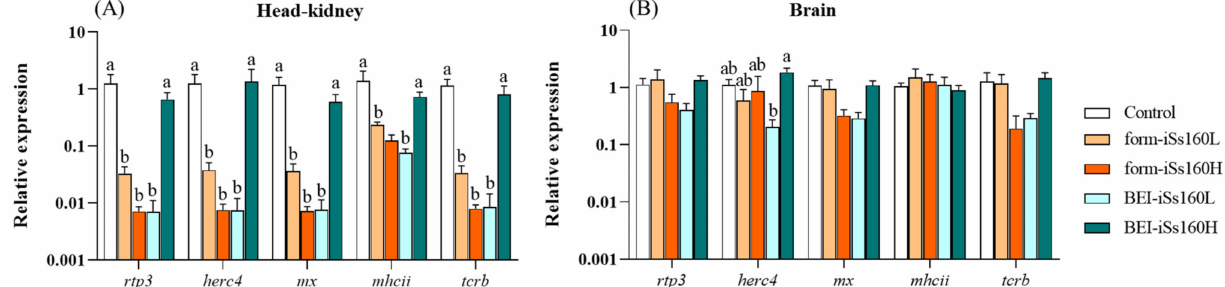
Figure 6. Vaccination mainly decreases the immune response upon NNV infection at a transcriptional level in head-kidney but not in brain. Expression of immune-related genes in ( A ) head-kidney and ( B ) brain of Senegalese sole specimens 45 days after 3 h of immersion with 10 5 TCID 50 /mL of Ss160 in fish previously vaccinated with PBS (Control) or with low and high dosages (10 5 and 10 7 TCID 50 /mL, iSs160L and iSs160H, respectively) of BEI-iSs160 vaccine (inactivated with BEI) and form-iSs160 (formalin inactivated) or PBS (Control). Data represent the mean ± standard error of the mean (SEM; n = 6 fish/group and time). Lower letters denote statistical differences between groups according to the two-way ANOVA test ( p <